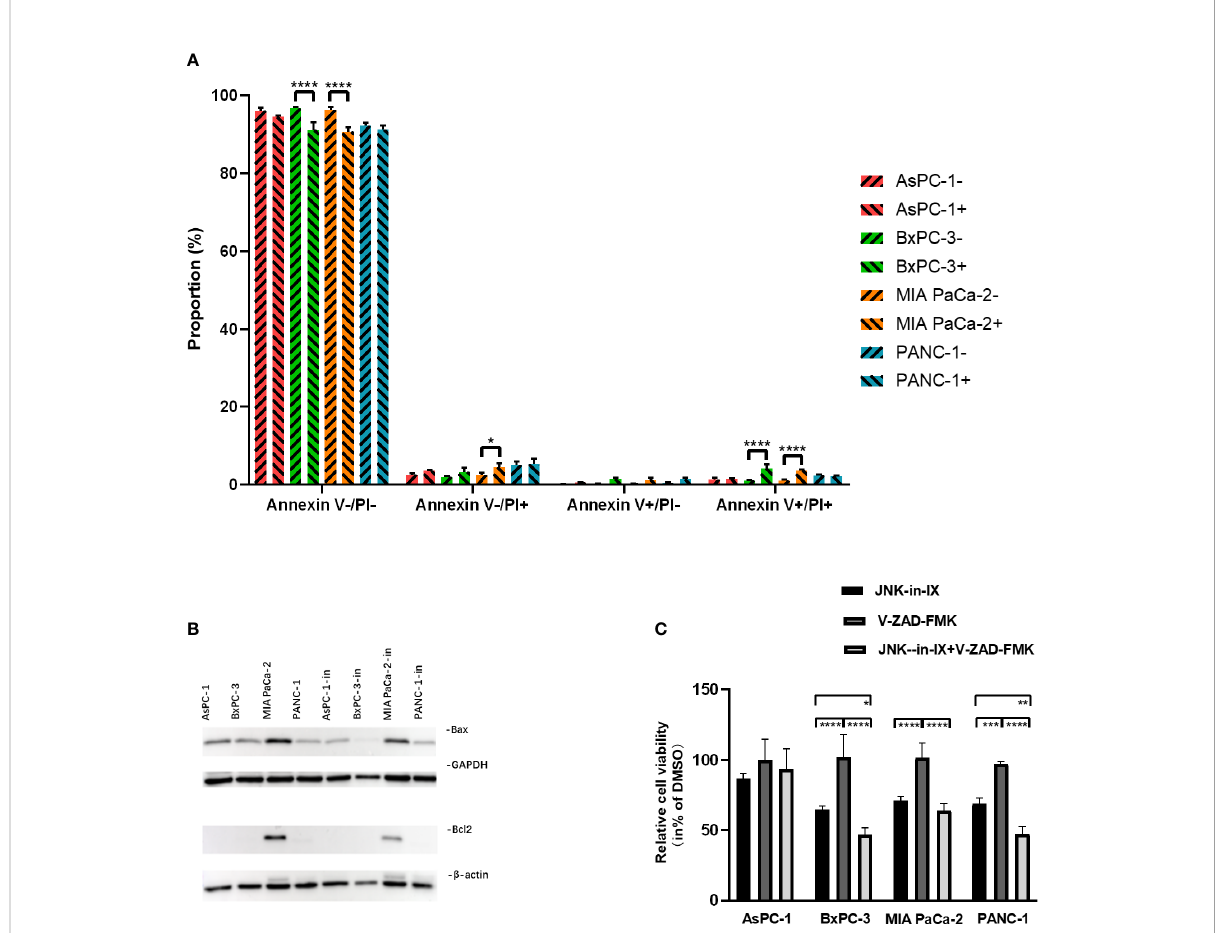
FIGURE 4 Effect of JNK-in-IX on apoptosis. (A) After incubation with JNK-in-IX (AsPC-1: 0.409 µM, BxPC-3: 0.220 µM, MIA PaCa-2: 0.071 µM, and PANC- 1: 0.066 µM) for 48 h, 10 6 cells were harvested and stained by Annexin V and PI. Data were analyzed by fl ow cytometry. Viable cells are stained Annexin V- / PI-, apoptotic cells are stained Annexin V+ / PI-, and dead cells are stained Annexin V+ / PI+. Only a slight increase in apoptotic cells was observed. Results are shown of 3 independent experiments. (B) Western blot analysis of Bax and Bcl2 after JNK-in-IX treatment. GAPDH and b -actin were used as internal control. (C) Pancreatic cancer cell lines treated by JNK-in-IX and V-ZAD-FMK. Percentage of viable cells compared to untreated control are shown. Data are expressed as mean ± SEM. of at least four independent experiments. *p<0.05, **p<0.01, ***p<;0.001,